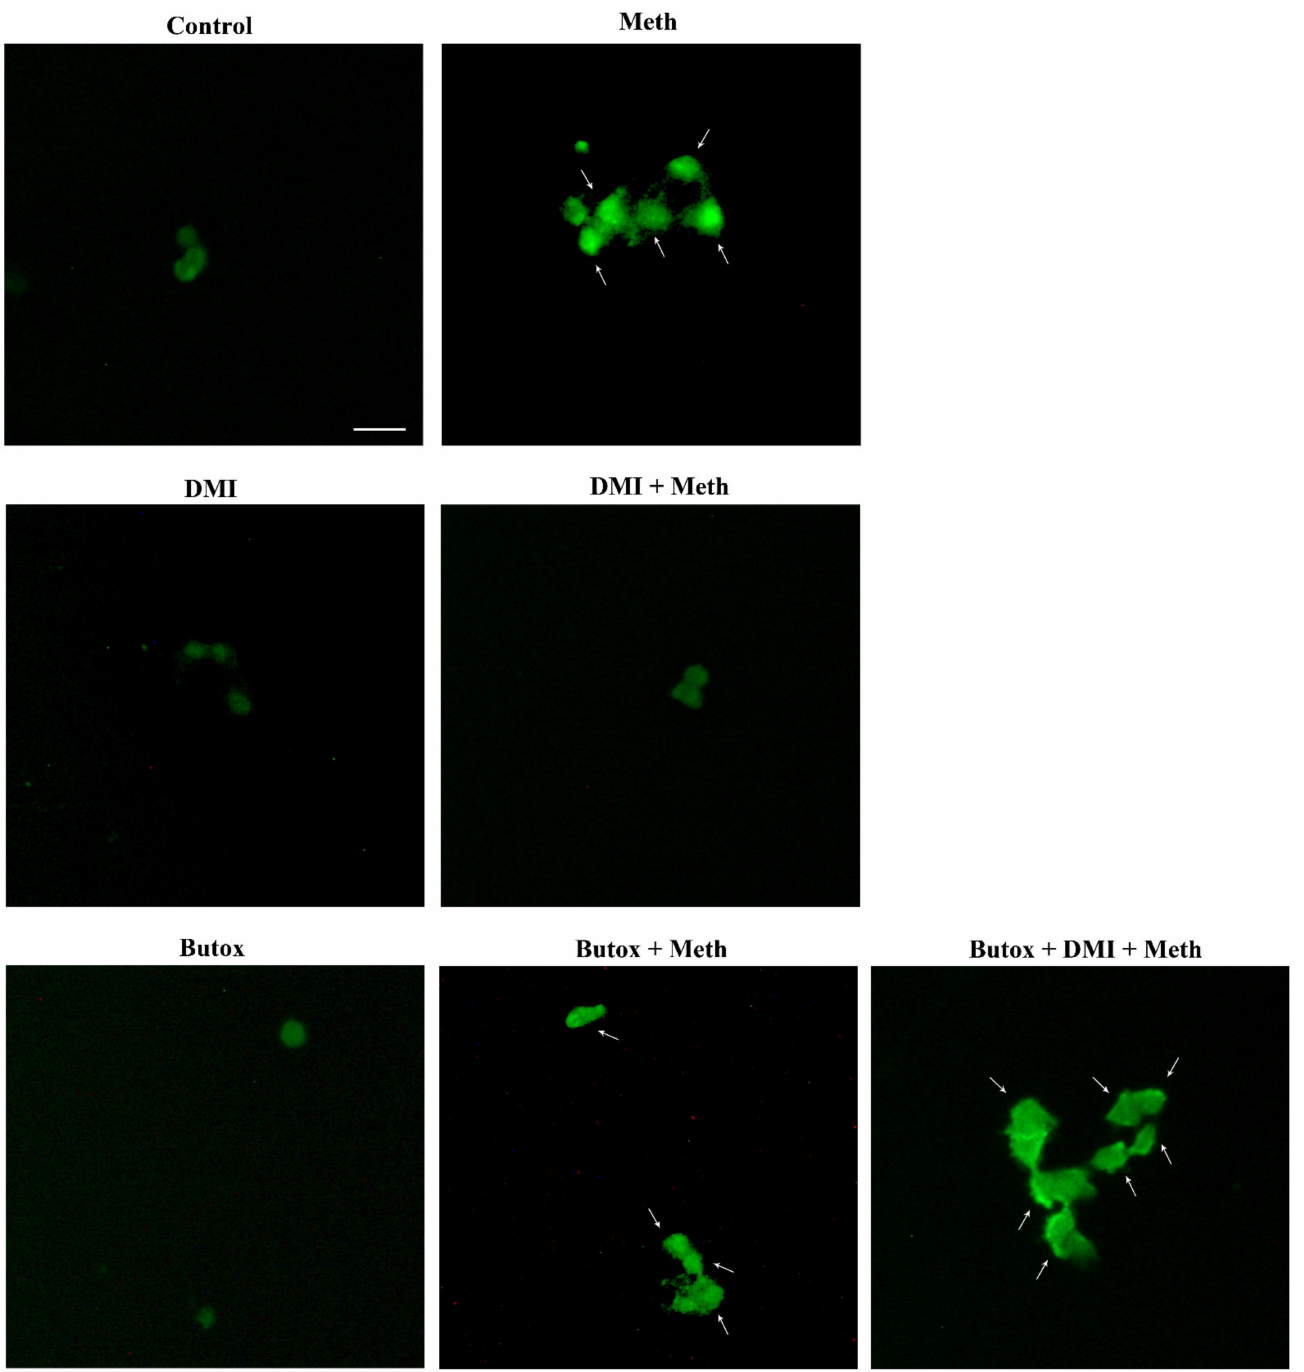
Figure 9. The NET blocker DMI protects against Meth toxicity through β 2-AR (FJB). DMI (100 nM) administration obscures intense histofluorescence by FJB staining induced during Meth toxicity. Histofluorescence is brought back in intensity by the β 2-AR antagonist butoxamine (10 µ M), which re-instates Meth (50 µ M)-induced toxicity. Arrows indicate FJB intensely positive cells. Scale bar = 20 µ